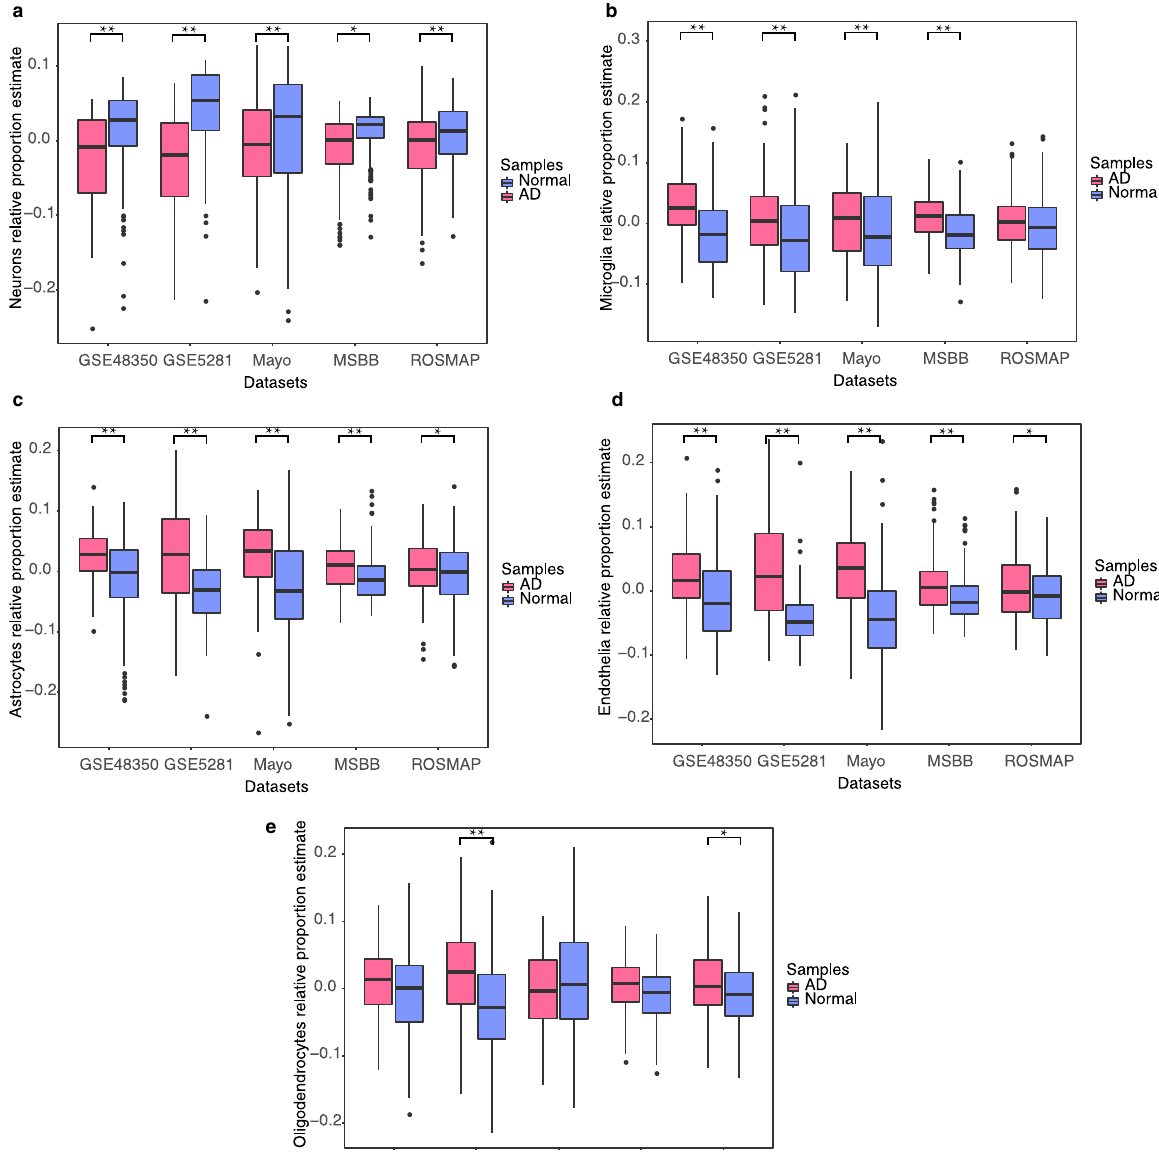
Figure 2. Cell type deconvolution analysis indicated decreased neuron proportions and increased glia proportions in the AD samples. The significance of cell-type proportion changes between AD samples and controls was measured by Wilcoxon rank sum test (* p < 0.05, ** p < 0.01). ( a ) The estimated neuron relative proportions in AD samples and controls. ( b ) Estimated microglia relative proportions in AD samples and controls. ( c ) Estimated astrocyte relative proportions in AD samples and controls. ( d ) Estimated endothelial cell relative proportions in AD samples and controls. ( e ) Estimated oligodendrocyte relative proportions in AD samples and